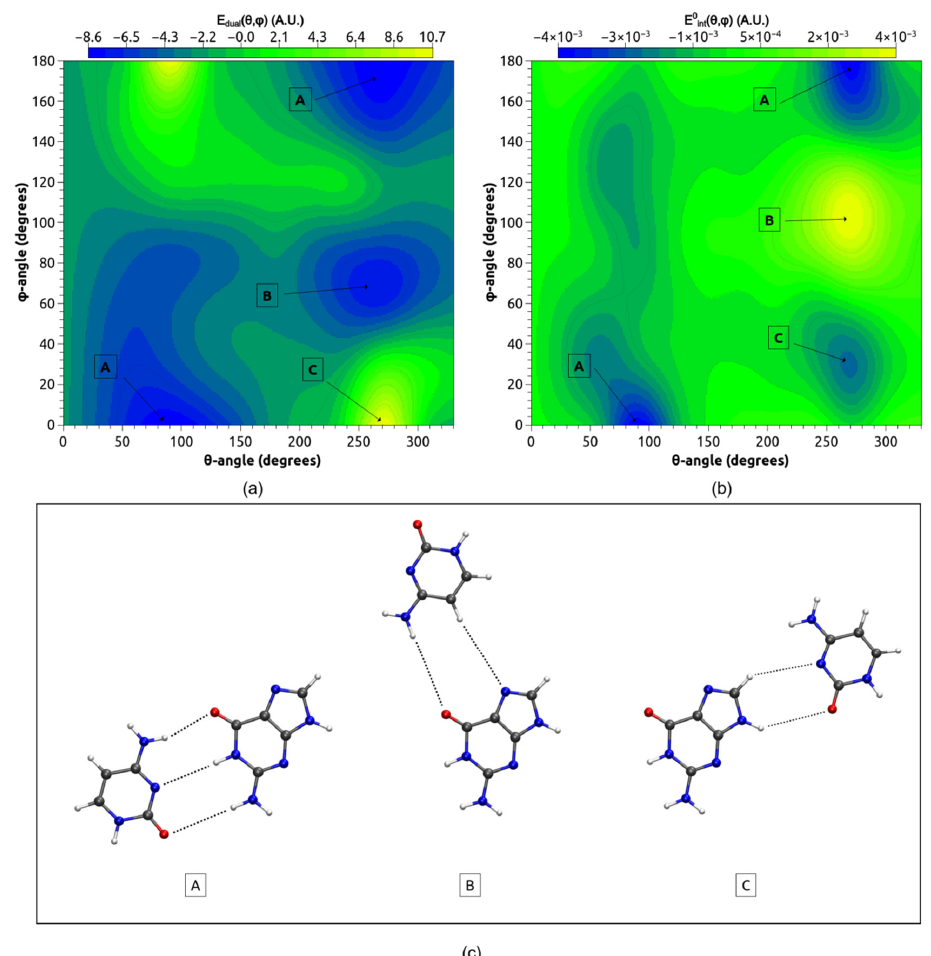
Figure 3. Two-dimensional map calculated at the M06-2X/6-311++G(3df,2pd) level of theory E dual ( θ , ϕ ) ( a ) the DFT in- termolecular interaction energy 𝐸 (cid:3036)(cid:3041)(cid:3047)(cid:2868) (cid:4666)𝜃,𝜑(cid:4667) between the cytosine and the guanine vs. ( b ) E dual ( 𝜃,𝜑(cid:4667) surfaces for base pair GC formation. ( c ) Stationary points obtained from the maps, the structure (A) is the global minimum. Carbon atoms are in grey, Nitrogen atoms in blue, Oxygen atoms in red and Hydrogen atoms in white.